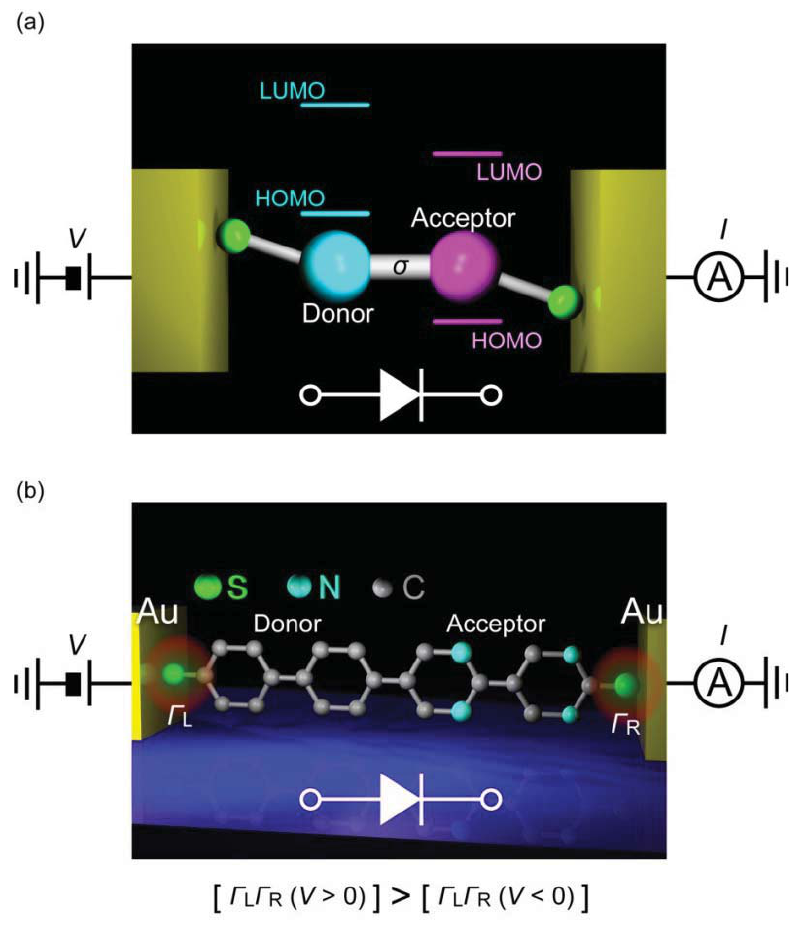
Figure 9. Single-molecule diodes. ( a ) Schematic model of the Aviram-Ratner molecular diode comprised of a donor- (cid:8) -acceptor (D- (cid:8) -A) structure. The molecular orbitals are localized on the donor and the acceptor units by virtue of the insulating barrier at the (cid:8) bond. Because of the asymmetric structure, the HOMOs and LUMOs of the D- (cid:8) -A system align with the electrode Fermi level more easily in one bias direction than the other, thereby causing current rectification; ( b ) A schematic illustration of the dipyrimidinyl- diphenyldithiol single-molecule junction with a donor-acceptor molecular architecture. A diode-like behavior was observed wherein the electron flow from the left to the right of the junction was suppressed. The rectification characteristics were explained by the voltage-induced change in the molecular orbital phase and amplitudes that